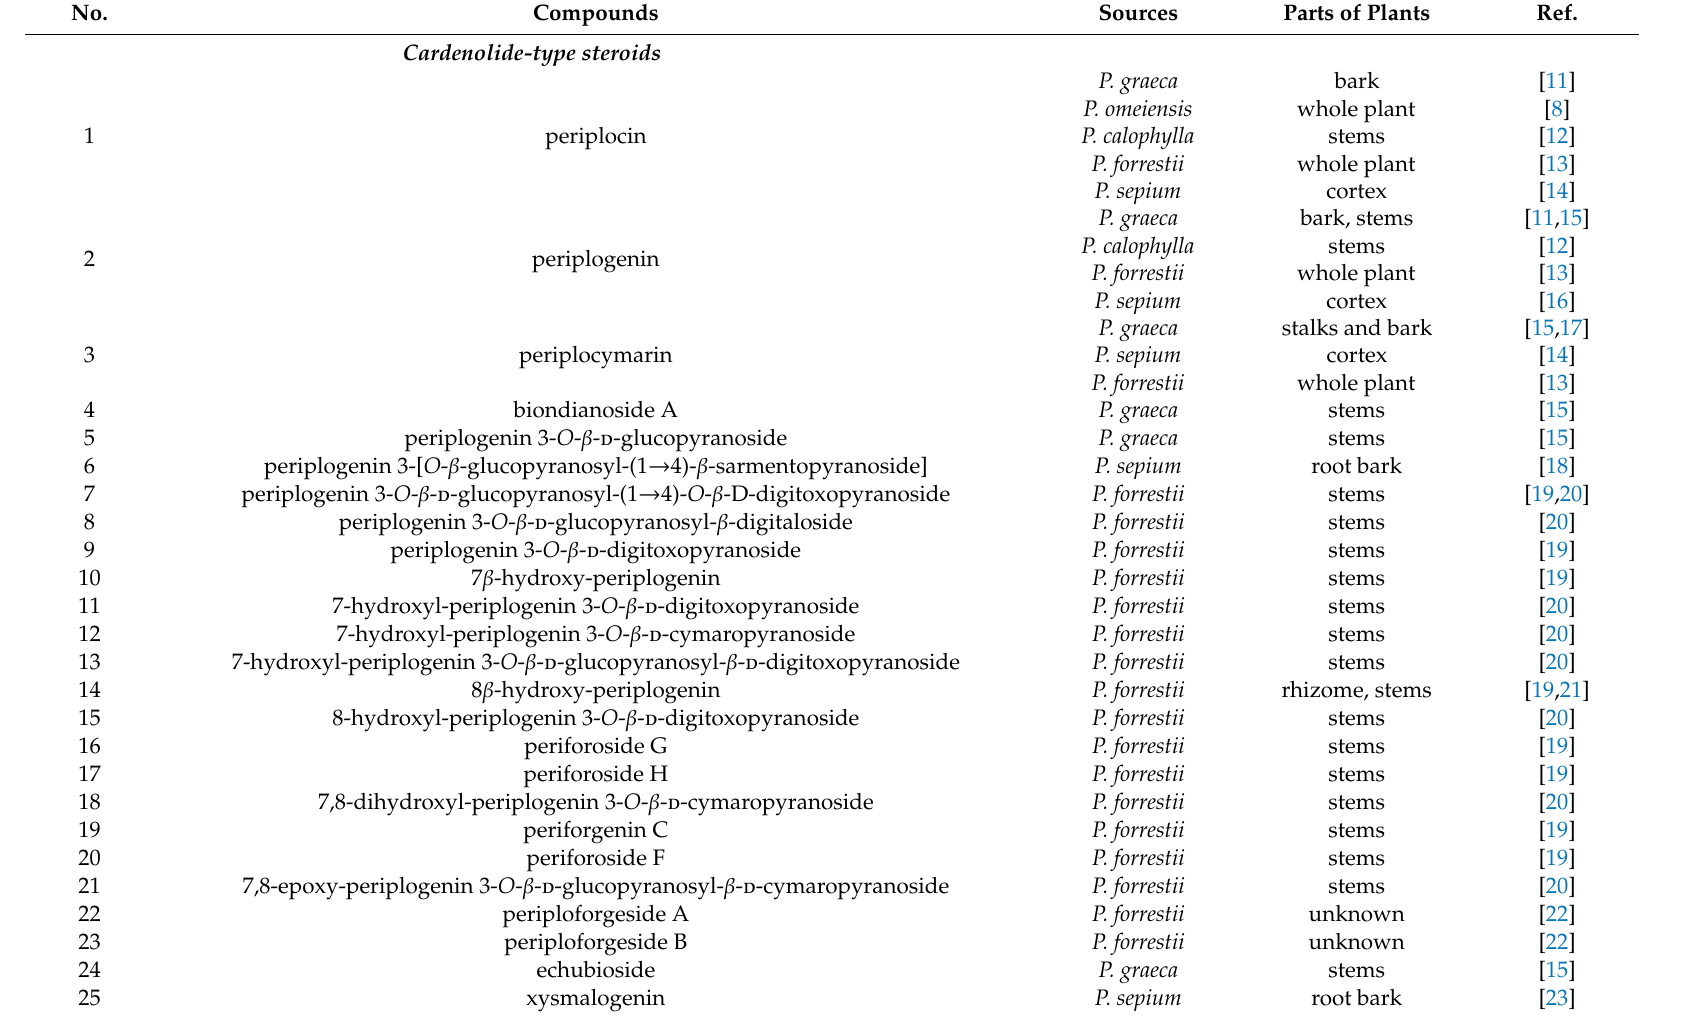
Table 2. Steroids from the genus Periploca